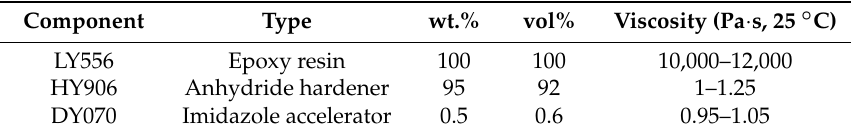
Table 5. Properties of the epoxy resin system used.